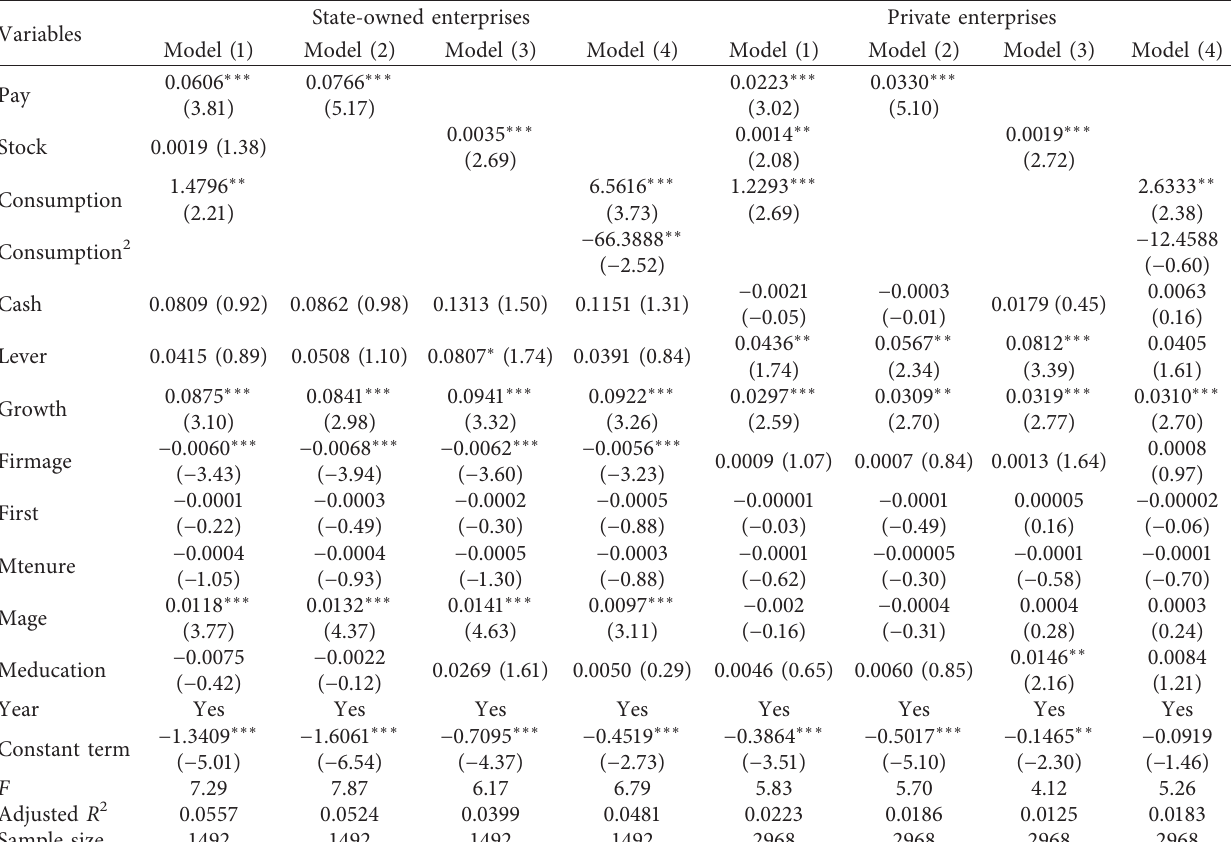
Table 6: Regression results of samples of different nature of property